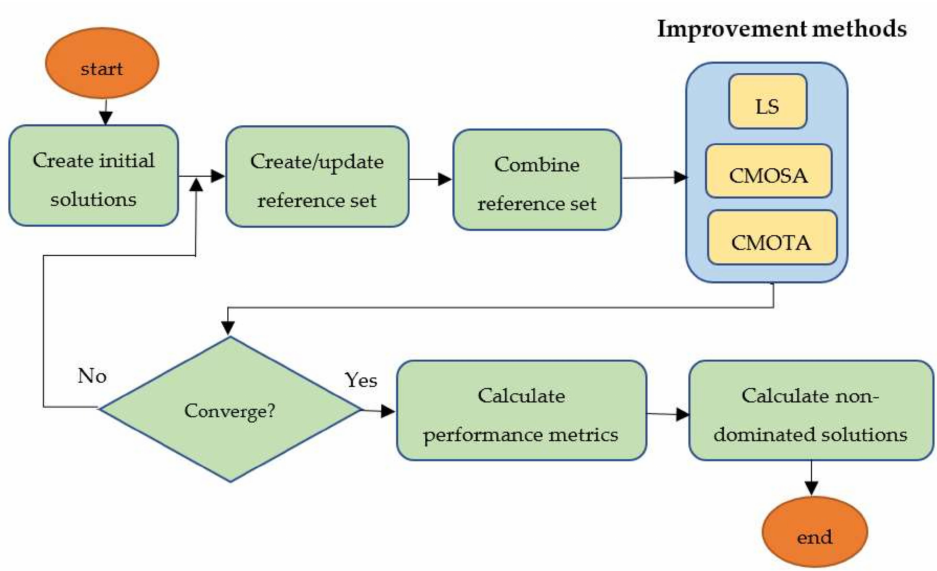
Figure 1. Scatter Search (SS) Framework.